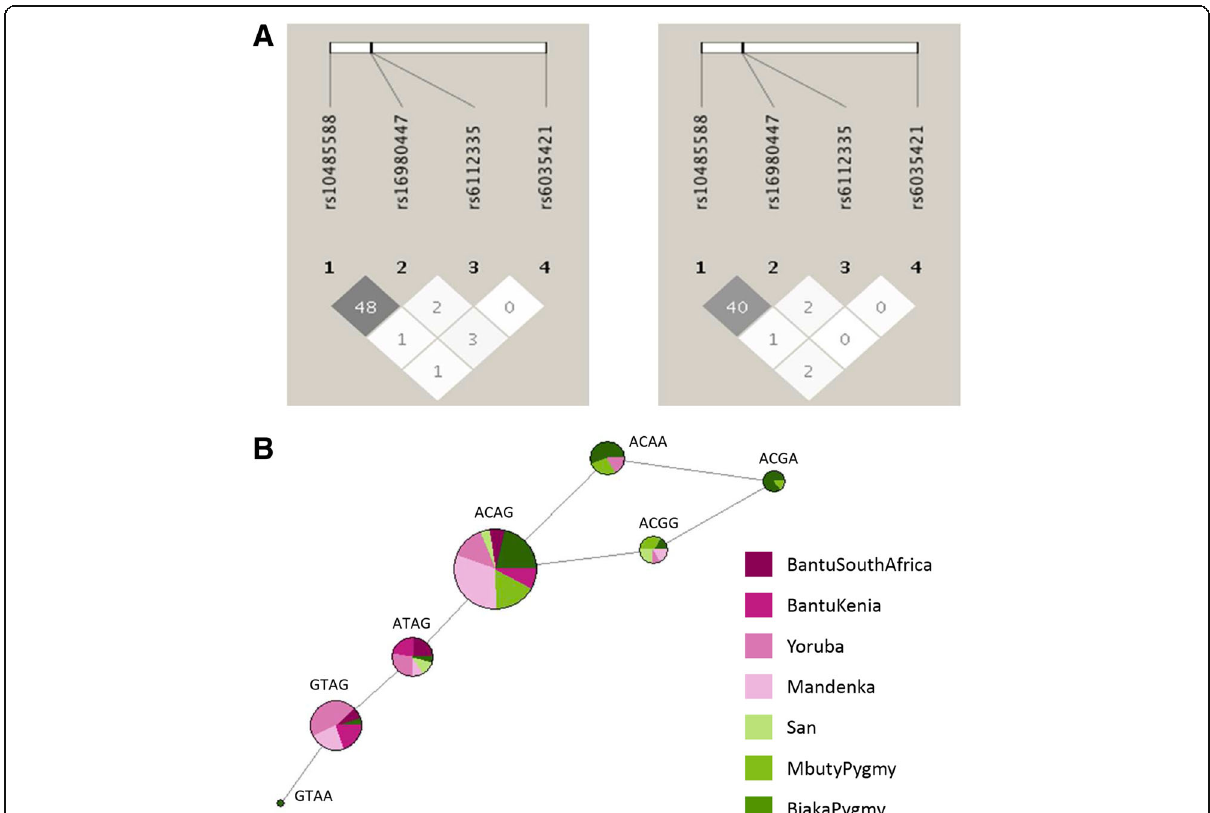
Fig. 2 Linkage disequilibrium plots and haplotype network of SLC24A3 regions in African populations. a Visualization of LD between the genetic variants in SLC24A3 regions bearing signals of positive selection. LD was calculated using r 2 parameter separately in African populations of farmers and hunter-gatherers. Squares shaded according to strength of LD. b Haplotype network analysis of SLC24A3 regions. Each circle represents a haplotype that is color-coded according to the population in which it is present. Circle sizes are proportional to the haplotype frequency and each line corresponds to one mutational